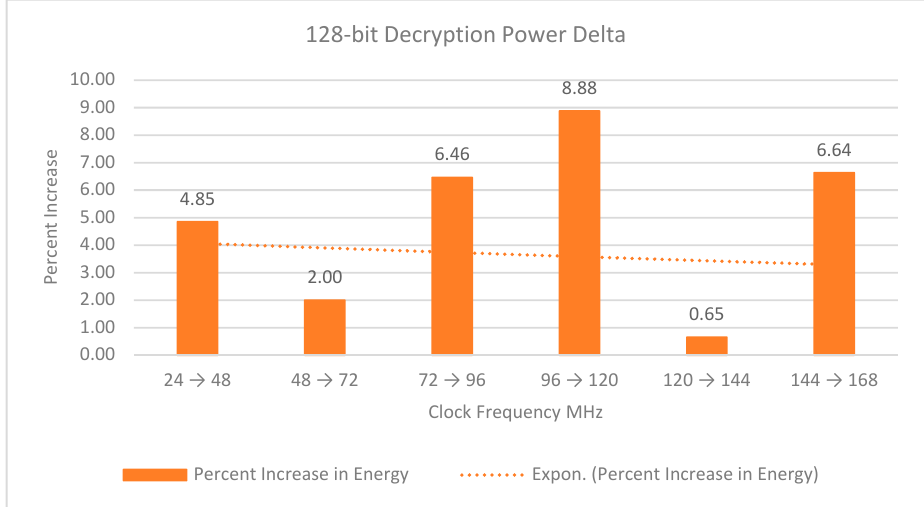
Figure A5. Relative change in system power during decryption with respect to clock frequency change.